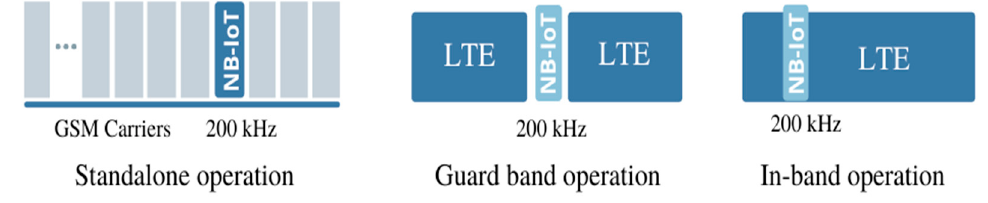
Figure 5. The operation modes of the NB-IoT carrier.